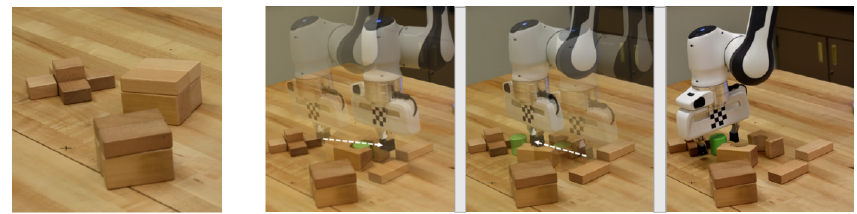
Figure 6. Grasping the invisible [78].